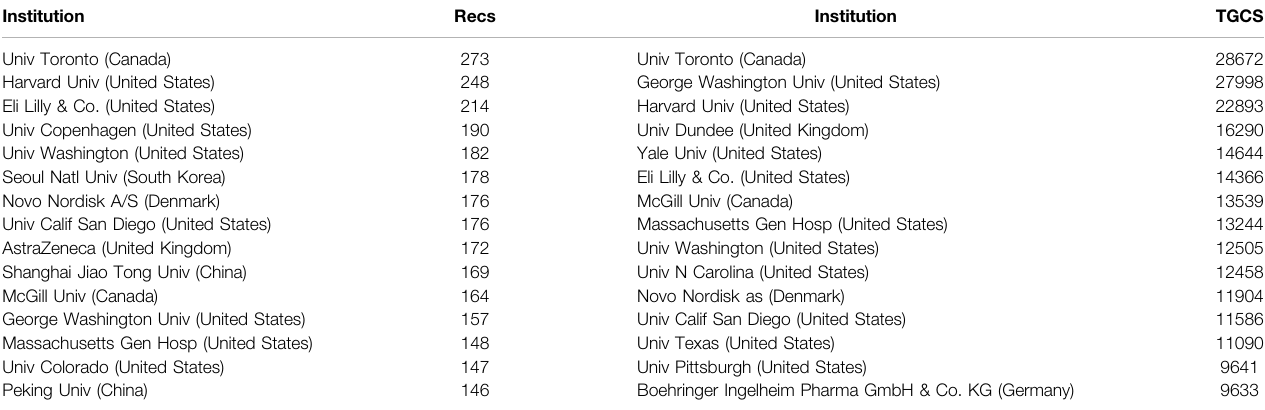
and ranked on the right of Figure 7 based on the log- likelihood ratio algorithm. Along the dashed line linked to each tag, circles with larger radius represent higher citation frequencies and warmer colored lines represent later publication dates. Table 5 . Two parameters, modularity Q and silhouette value were calculated to evaluate the structure signi fi cance and robustness of these clusters, respectively. A cluster structure with the modularity Q higher than 0.3 was considered signi fi cant, and with the modularity Q of 0.7025 ( Figure 7 ), ours have cluster